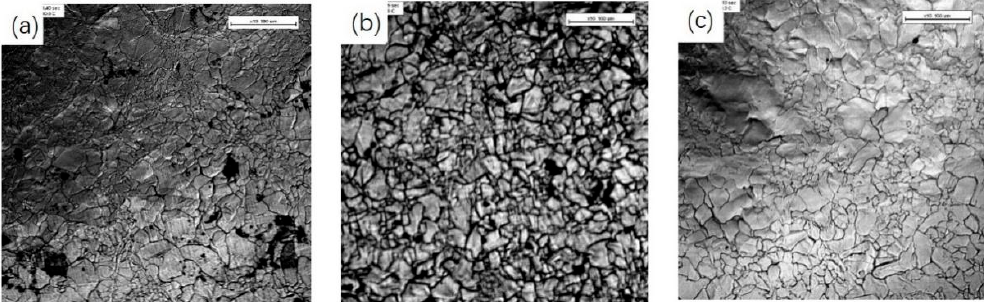
Figure 16. Austenite grains morphology at different holding times: ( a ) 300 s; ( b ) 600 s; and ( c ) 900 s. Table 3. The average grain size in HAZ and original austenite.